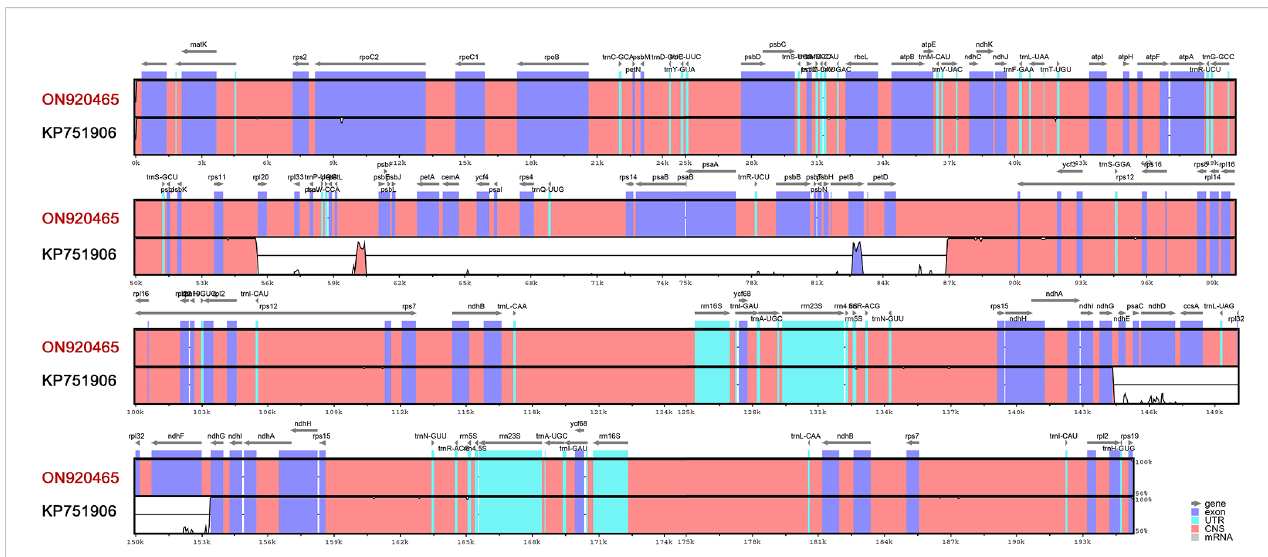
FIGURE 8 mVISTA identity diagram based on LAGAN alignment for Carex siderosticta assembled by two different methods and data sources. ON920465 was used as the reference sequence, which was derived from a hybrid assembly of second and third generation data. A cut-off value of 70% similarity was used for the plot, and the Y scale indicates the percent similarity between 50 and 100%. Blue represents coding regions and pink represents non-coding